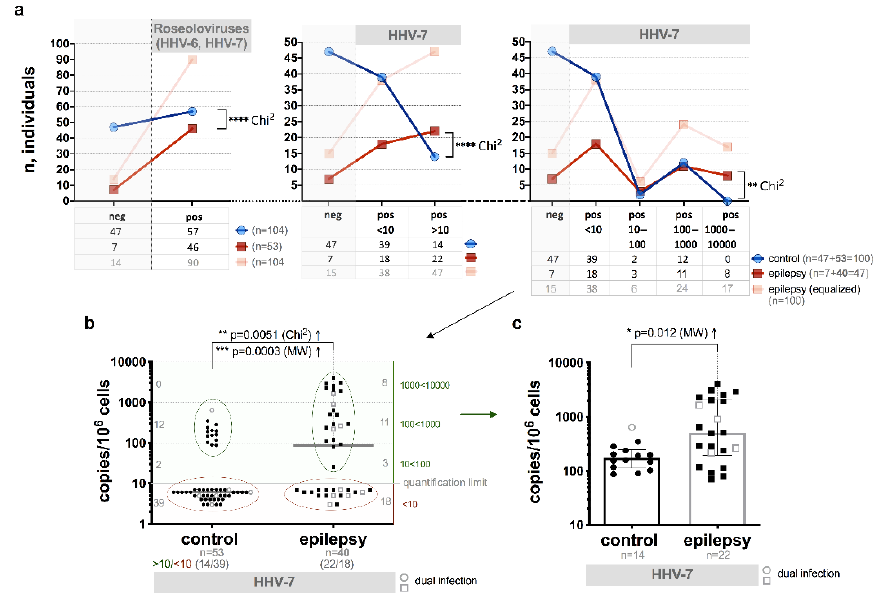
Figure 2. HHV-7 load in whole peripheral blood (WPB) of the patients with epilepsy (including cases with dual HHV-7 and HHV-6 infection) and control group individuals: ( a ) comparison of frequency of HHV-7 positive (pos) and negative (neg) cases in epilepsy patients and control individuals; ( b ) comparison of viral load and frequency of HHV-7 positive epilepsy patients and control individuals, with red ovals are marked low viral load ( < 10 copies / 10 6 cells) cases, with green ovals—elevated viral load ( > 10 copies / 10 6 cells) cases; ( c ) comparison of elevated viral loads of HHV-7 in epilepsy patients and control individuals; light symbols indicate cases with double HHV-7 and HHV-6 infection ( b,c ); asterisks in a represent a significance level of di ff erences between groups (** p < 0.01, **** p <